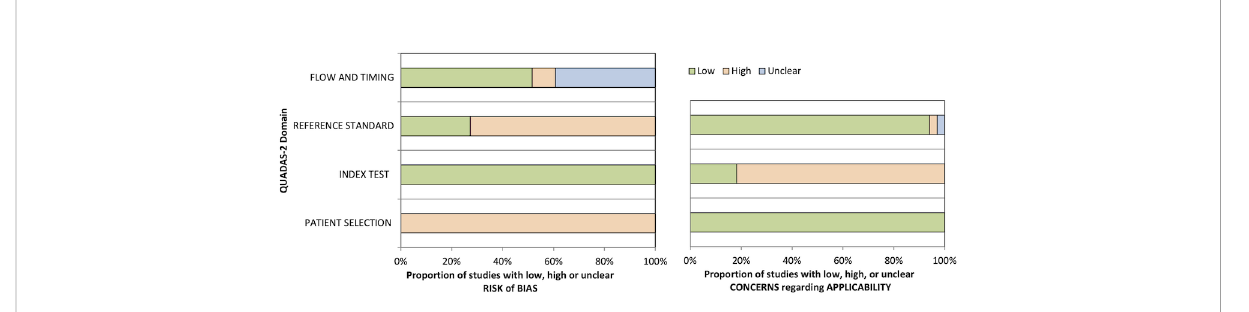
TABLE 5 QUADAS-2 assessment for segmentation studies. Study Risk of bias Applicability concerns